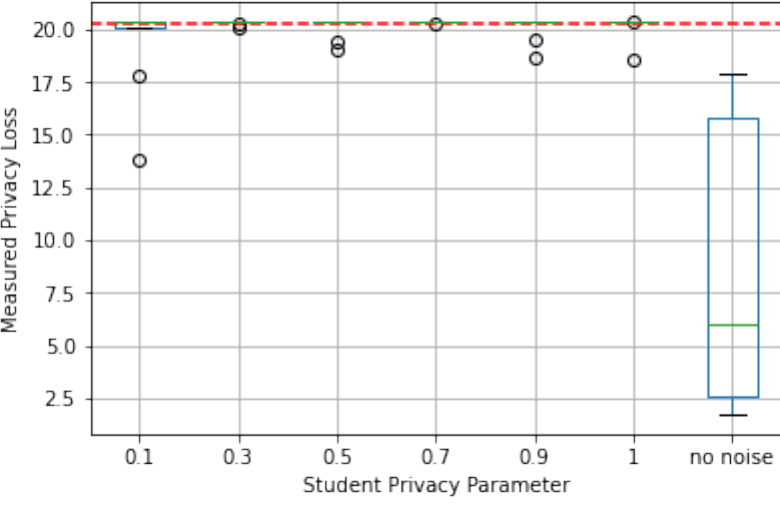
Figure 11. Privacy loss by student privacy parameter ρ in ECG